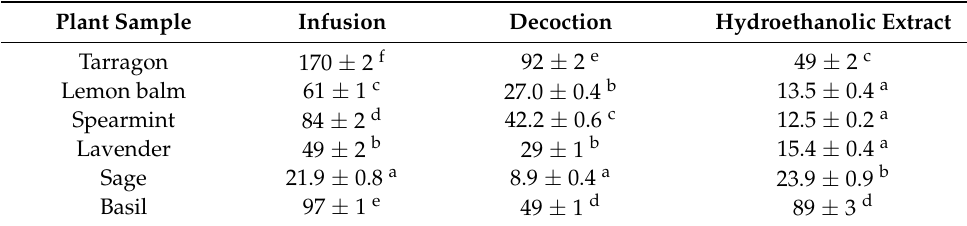
Table 1. Antioxidant activity of the plant extracts (IC 50 values, µ g/mL). Plant Sample